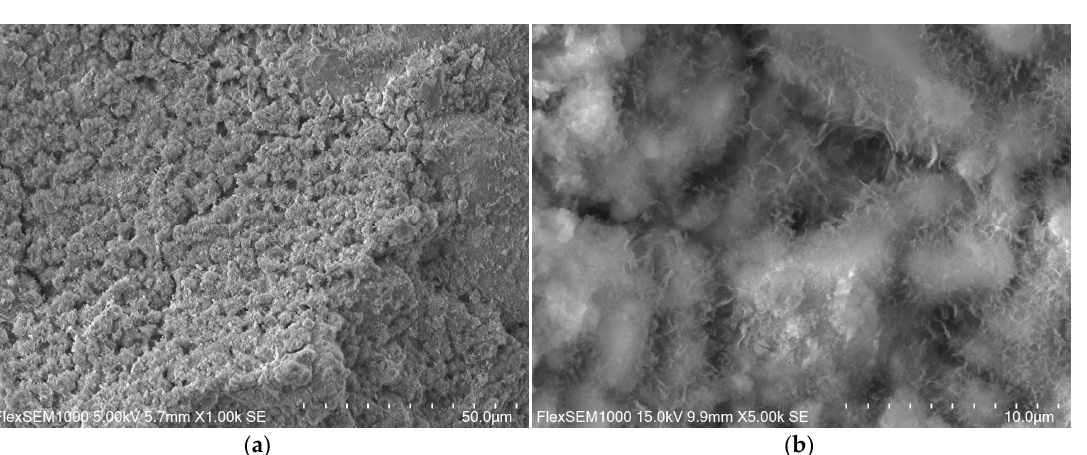
Figure 9. The image of ZK1 grain sand with the remains of the binder with the indicated places of chemical microanalysis.